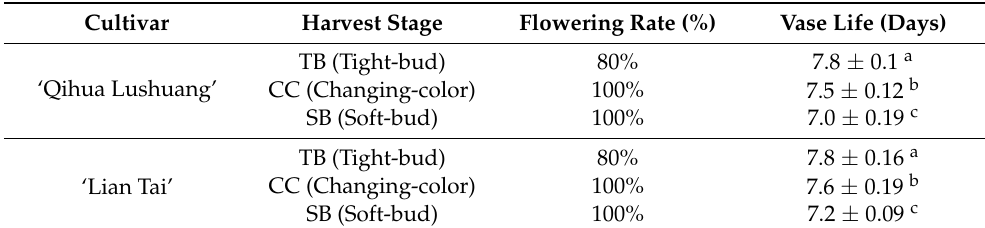
Table 2. Effects of harvesting stage on flowering rate and vase life of “unfold-petal type” cut P. lactiflora.